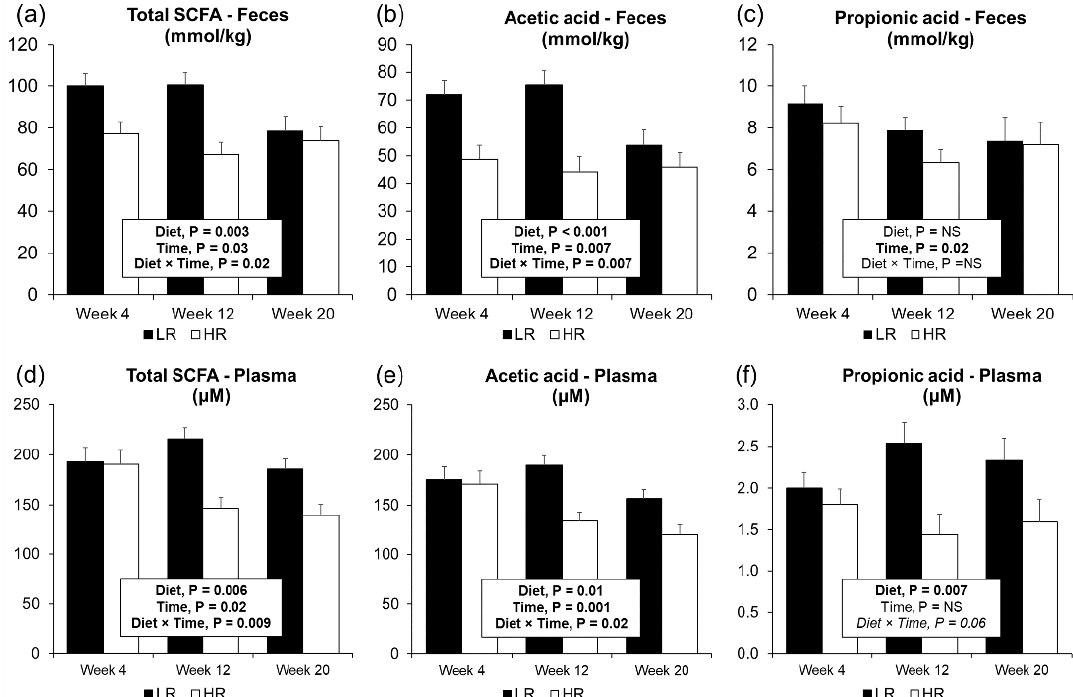
Figure 3. Short-chain fatty acids (SCFA) measured in feces and plasma from Gottingen Minipigs fed the HR or LR diets. Fecal SCFA were measured by gas chromatography ( a – c ). In fasting plasma SCFA were analyzed by targeted liquid chromatography mass spectrometry ( d – f ). Abbreviations: NA, non-significant ( p -values > 0.1).